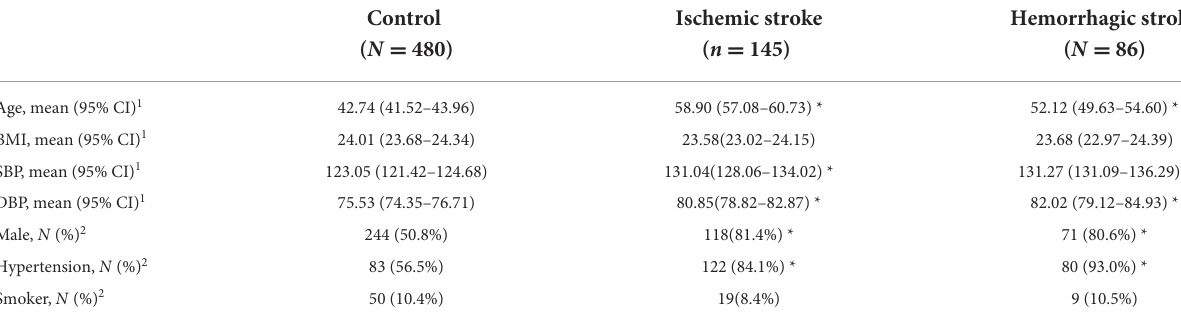
TABLE 1 Comparison of clinical characteristics between control, ischemic and hemorrhagic stroke.